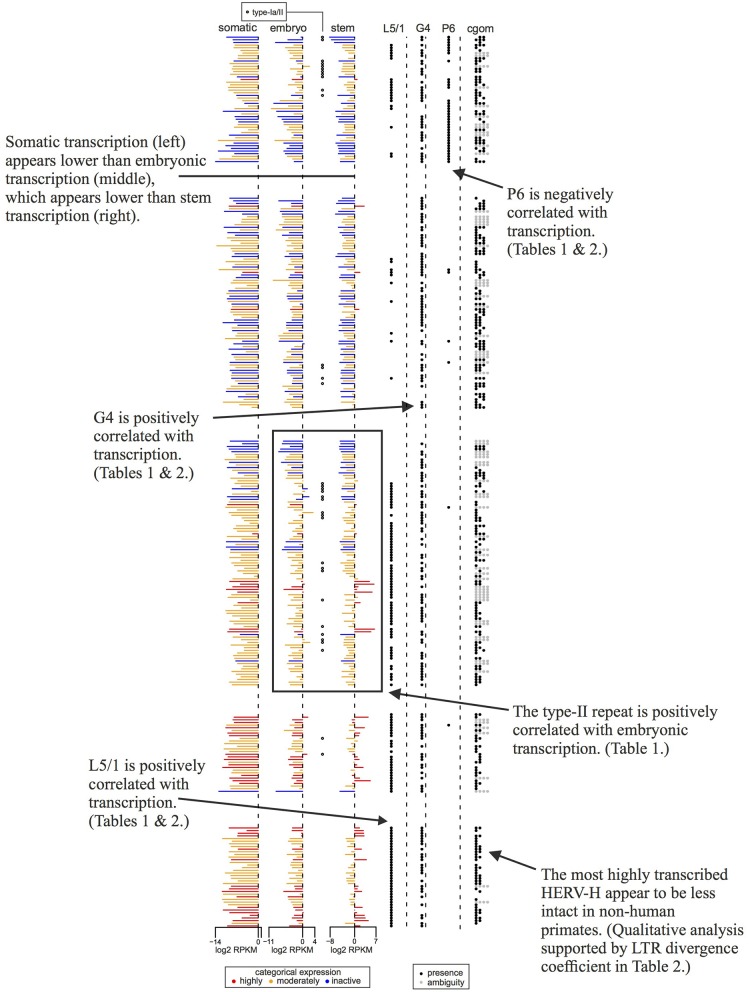
Concise guide to Figure 3 showing transcription levels and per locus genomic features of a subset of the 409 HERV-H loci. Rows are ordered, colored, and sourced as per Figure 3, though some rows are omitted to aid clarity. Annotations highlight aspects of our results that are discussed in detail in the main article text.